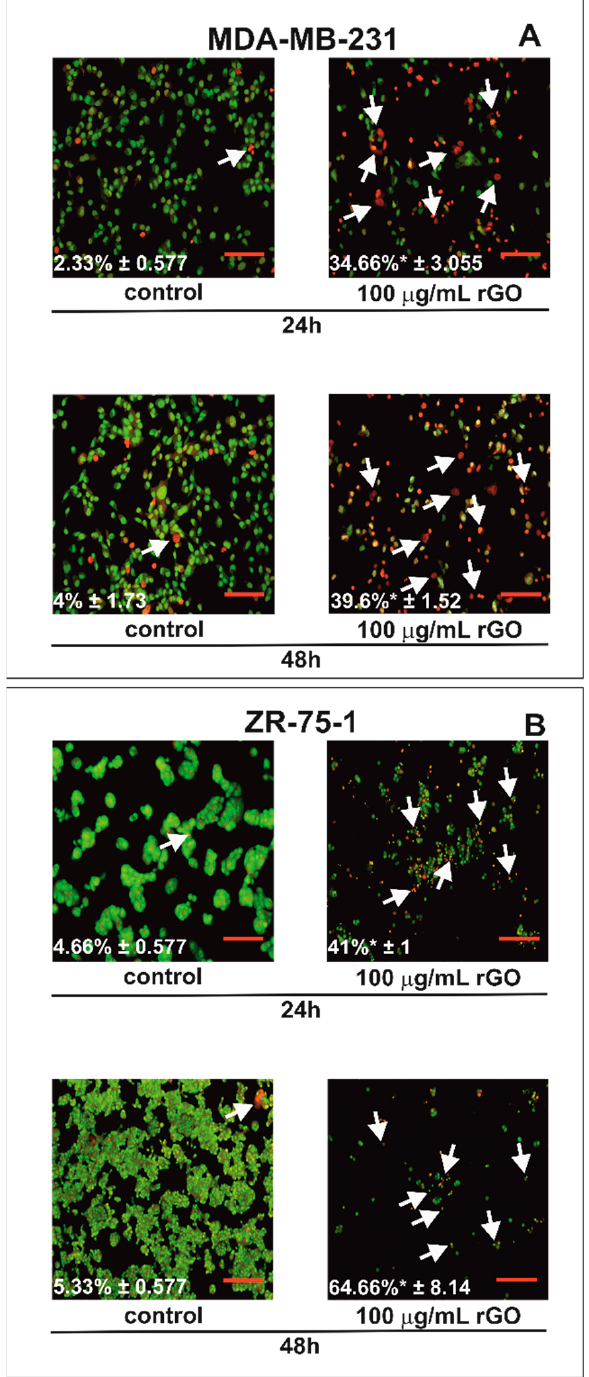
Figure 3. The effect of rGO on apoptosis in MDA-MB-231 ( A ) and ZR-75-1 ( B ) cells evaluated using fluorescence microscopy. The cells were incubated with 100 µ g/mL of rGO for 24 and 48 h and stained with acridine orange and ethidium bromide. The cells were imaged using fluorescence microscopy at 100-fold magnification and analyzed to identify living and apoptotic cells. The percentage of apoptotic cells is shown in the lower left corner of the images. White arrows indicate apoptotic cells. We presented representative images from one of three independent experiments. Mean values from three independent experiments ± SD are presented. * p < 0.05. Scale bar is 50 µ m.